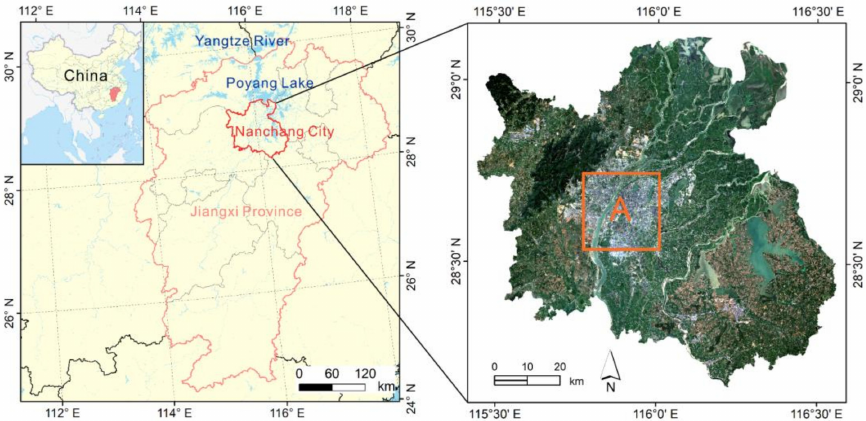
Figure 1. Left: Location of the study area (Nanchang City, China). Right: Sentinel-2 MSI image of the study area (R/G/B = bands 4/3/2). The square labeled “A” indicates a subregion shown in Figure